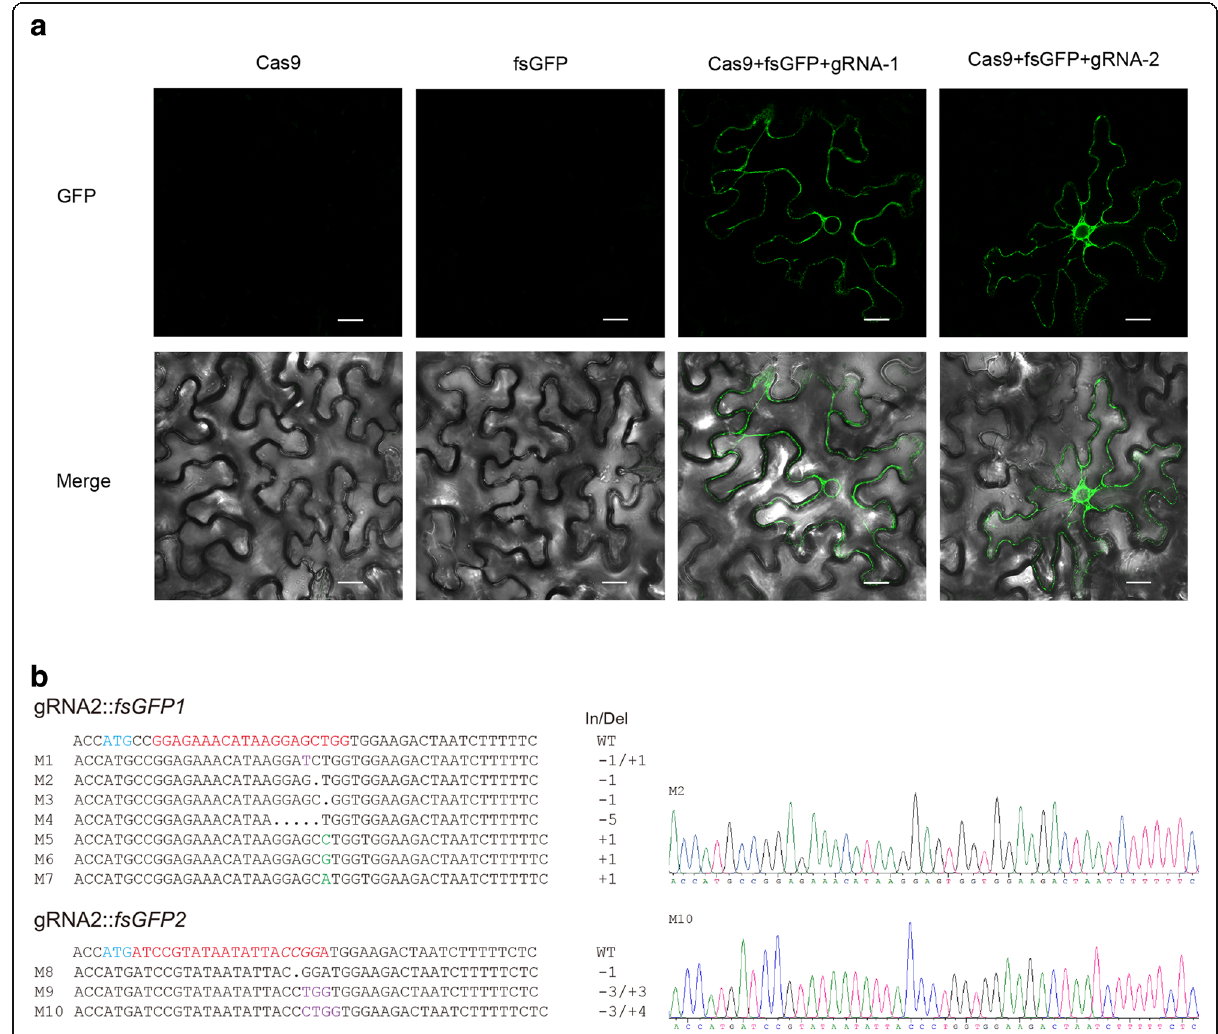
Fig. 3 CRISPR/Cas9-mediated targeted cleavage of the CLCuMuV genome. a GFP signals from N. benthamiana plant leaves. No fluorescence was observed in leaves infiltrated only with A. tumefaciens lines containing Cas9 and fsGFP respectively. Cas9 + fsGFP+gRNA-1 is the representative confocal image of leaf cells infiltrated with a mixture of two Agrobacterium cultures — one with a vector containing a fsGFP gene and the other with a vector containing the Cas9 gene and gRNA-1 . Cas9 + fsGFP+gRNA-2 is the representative confocal image of leaf cells infiltrated with a mixture of two A. tumefaciens cultures — one with a vector containing a fsGFP gene and the other containing the Cas9 gene and gRNA-2 . Leaves were photographed at 48 h after A. tumefaciens infiltration. Bars = 20 μ m. b Partial DNA sequences of two fsGFP genes and repaired